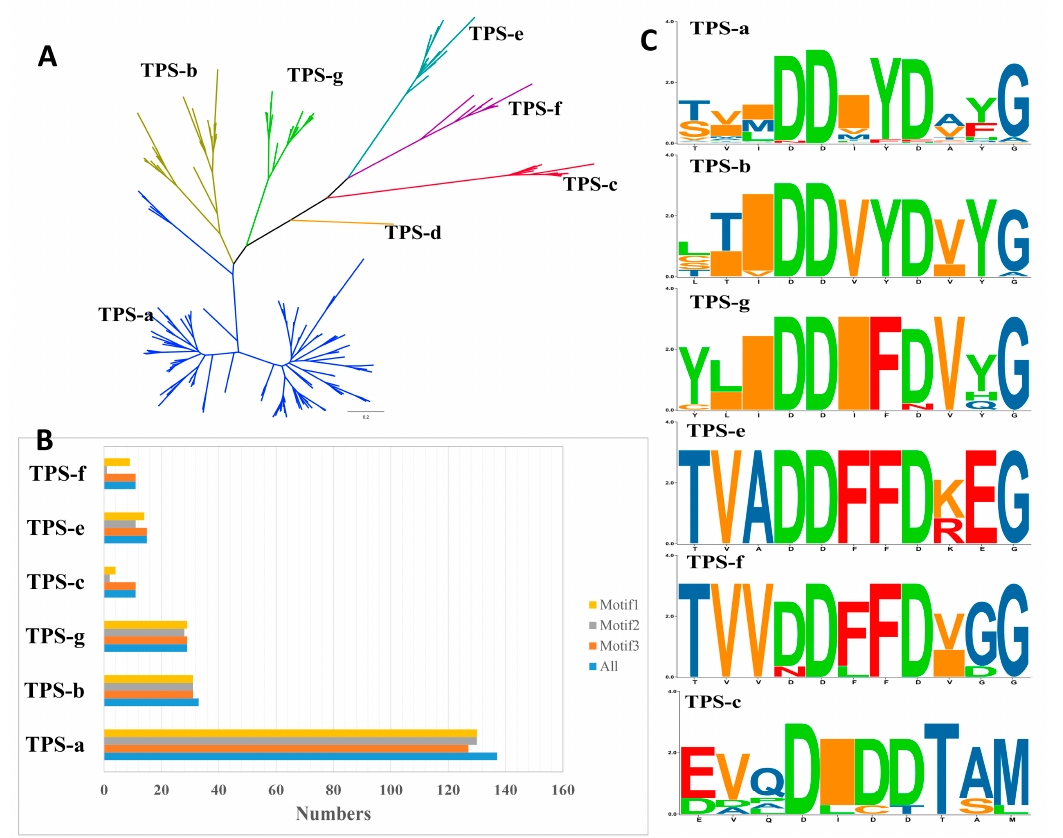
Figure 2. The unrooted phylogenetic tree of TPSs and motifs comparison between different TPS clades. ( A ). The maximum-likelihood phylogenetic tree of the TPS proteins in three Rosaceae species ( P. persica , M. domestica , F. vesca ). The TPS-a, TPS-g, TPS-b, TPS-c, TPS-e, and TPS-f clades are shaded in blue, green, yellow-green, red, benzo, purple, respectively. ( B ). The frequency of different motifs among different TPS clades. ( C ) The seqLogo of ‘DDxxD’ motif in the C-terminal domain of different TPS clades, the bit score represents the information content for each position in the sequence.